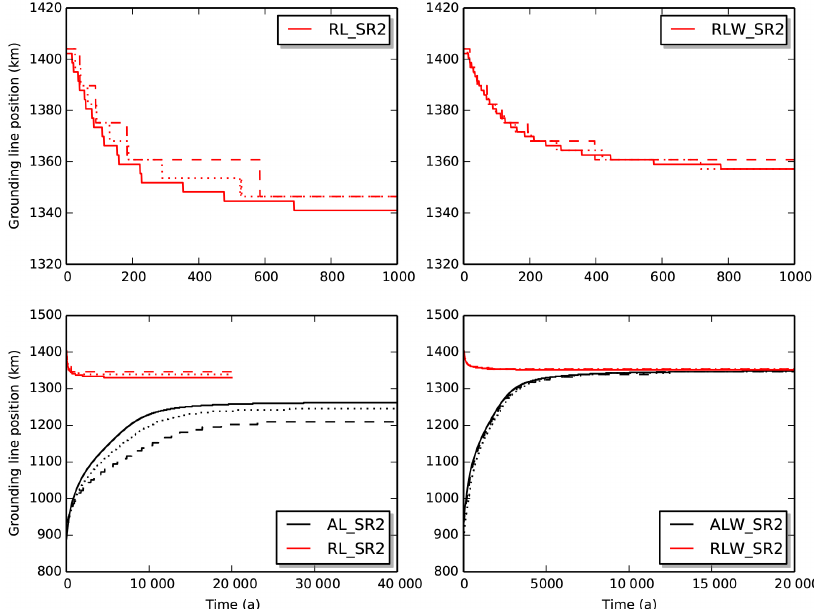
Figure 5. Evolution of grounding line position during the sub-shelf melting simulations with effective pressure dependency in the basal sliding relation. Right-hand panels show results with the water column scaling factor S w , active. Left-hand panels show the abrupt melting transition. The upper panels show the detail of the early stages of the retreat simulations, whereas the lower panels show the full simulations. The sliding relation (SR2) is described in Sect. 2.1 and Table 1. Experiments are described in Sect. 2.3 and Table 3. Resolutions (Table 2) are coarse (R0, dashed line), medium (R1, dotted line) and fine (R2, solid